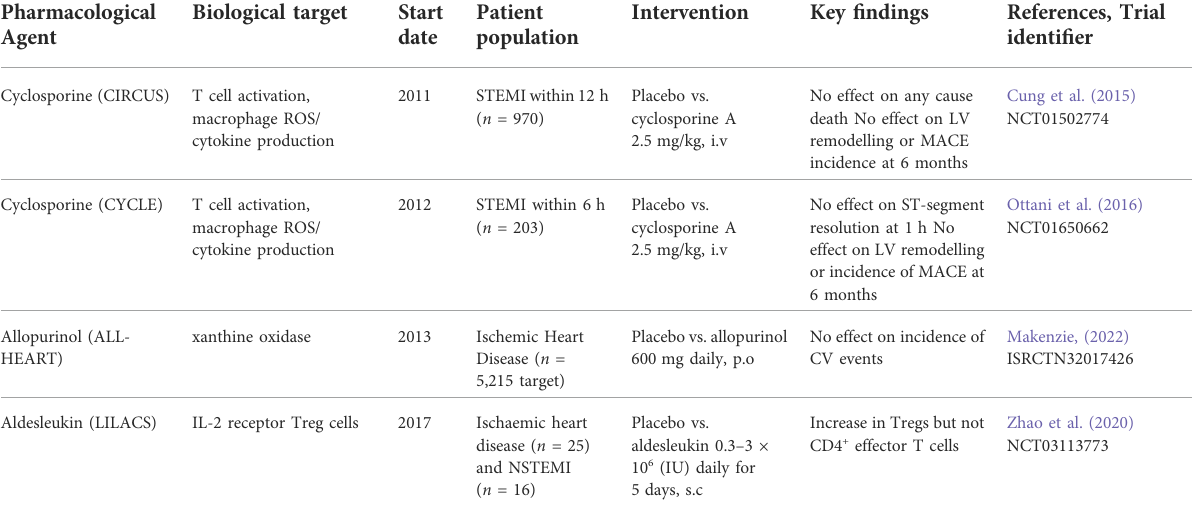
*ziltivekimabhasbeendevelopedspeci fi callyforcardiovasculardiseaseandhasnotyetgainedregulatoryapproval.NSTEMI,non-STsegmentelevationmyocardialinfarction;STEMI,ST segment elevation myocardial infarction; s.c, subcutaneous; CRP, C-reactive protein; MACE, major adverse cardiovascular event; LV, left-ventricular; MI, myocardial infarction; CV, cardiovascular; i.v, intravenous; p.o, per os; WBC, white blood cell; T2D, Type 2 Diabetes; LVEF, left ventricular ejection fraction; ROS, reactive oxygen